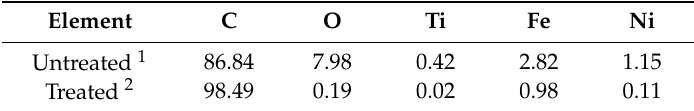
Figure 1. Scanning electron microscope (SEM) analysis of the structure and composition of the oxide particle-loaded carbon fibers: ( a ) SEM image and ( b ) qualitative results of chemical composition analysis. Table 1. Atomic percentage of each element from area mapping.